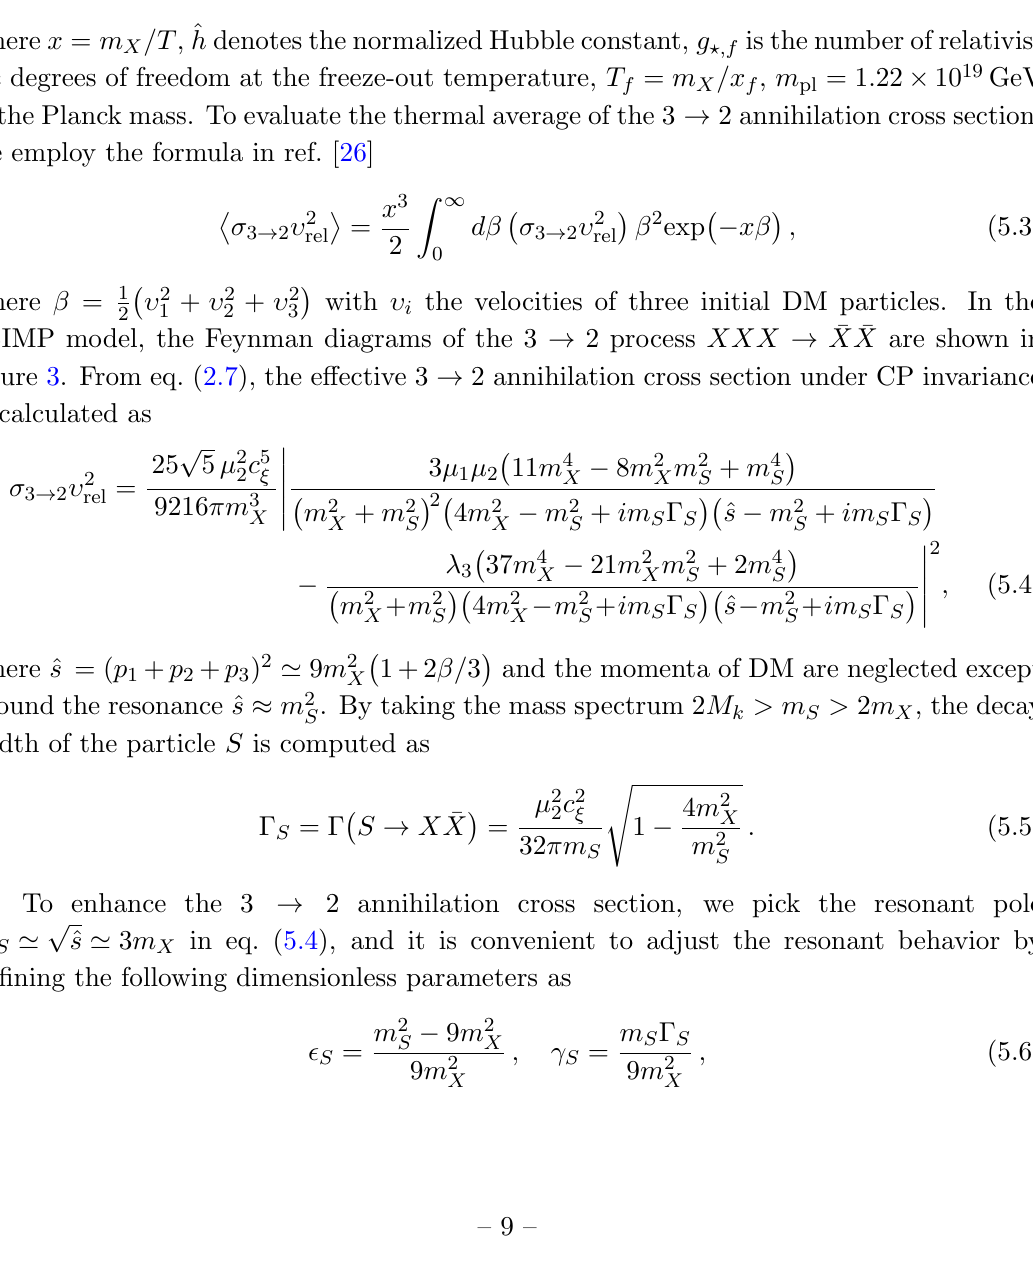
is the number of ?;f